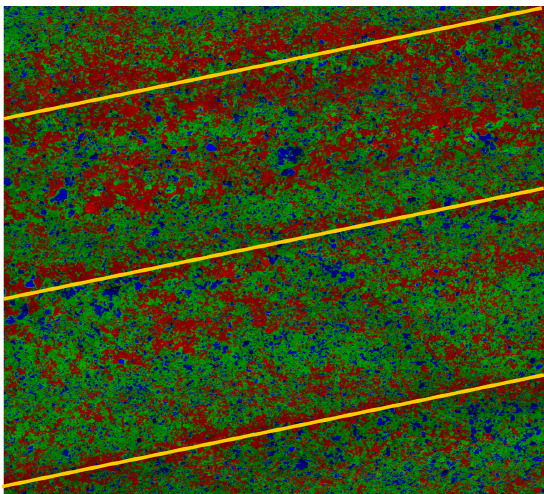
Figure 7. Microstructure subjected to cluster analy- sis with depicted dominating planes (yellow